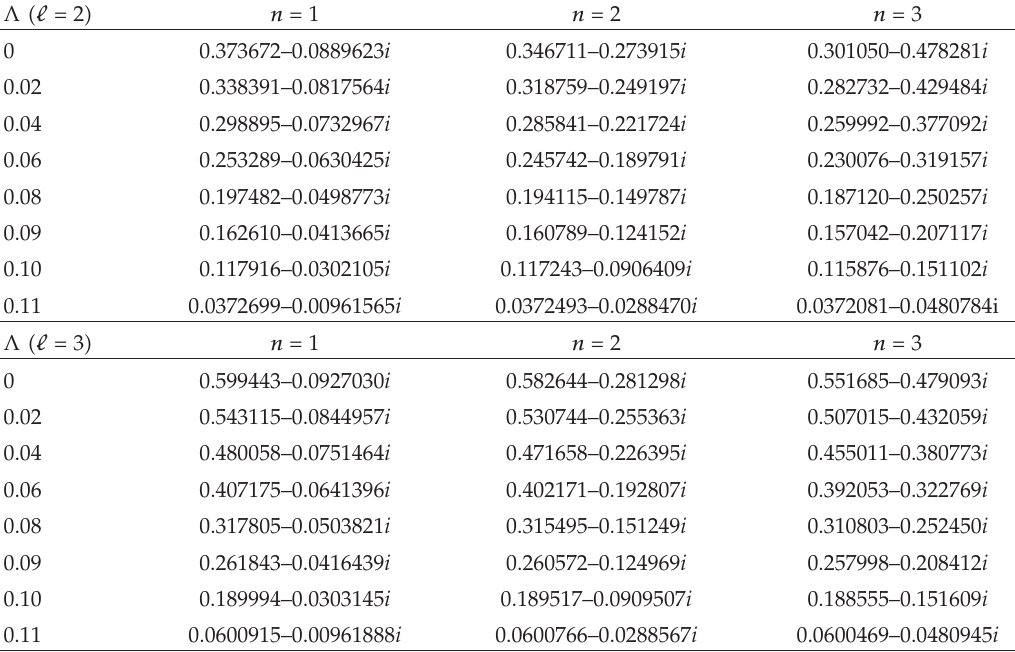
Table 2: QNMs to 6 signifcant figures for Schwarzschild de Sitter gravitational perturbations (cid:2) s (cid:8) 2 (cid:3) for (cid:12) (cid:8) 2 and (cid:12) (cid:8) 3 modes. We only present results for the AIM method, because the results are